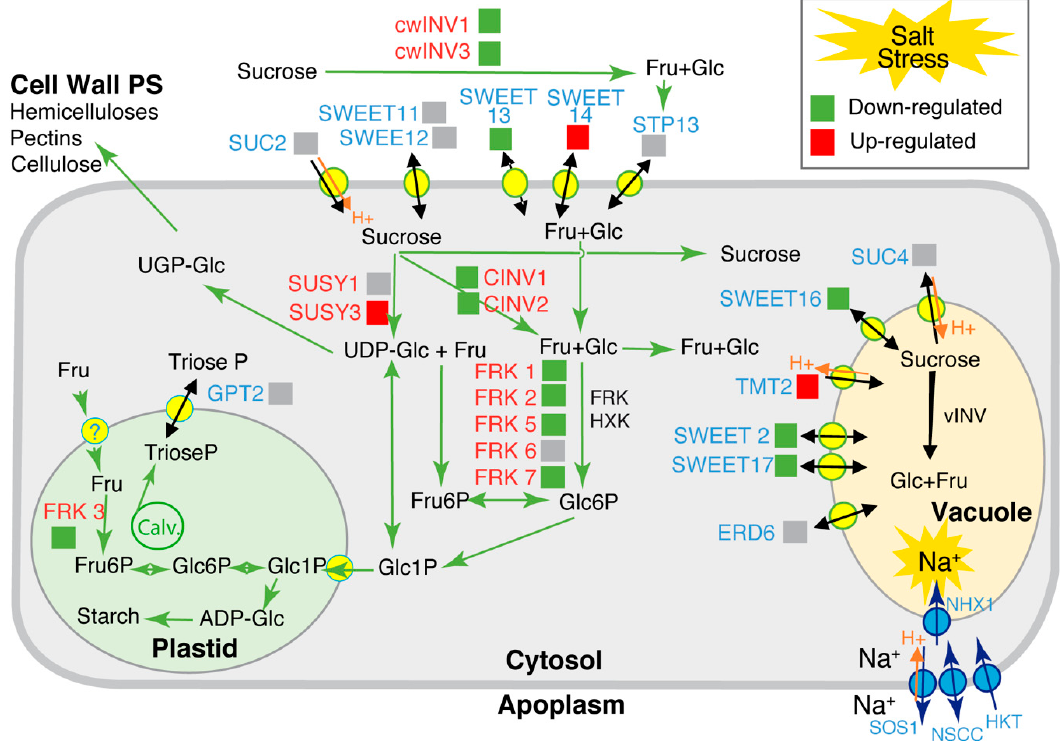
Figure 5. Scheme summarizing the expression data for genes involved in sugar transport ( TMT2 , SWEET2 , SWEET13 , SWEET14 , SWEET16 , SWEET17 ) and sugar homeostasis ( cwINV1 , cwINV2 , SUSY3 , CINV1 , CINV2 , FRK1 , FRK2 , FRK3 , FRK5 and FRK7 ) in the heterotrophic stem tissue under compared to controls. Red squares indicate genes upregulated in response to salt stress and green squares correspond to downregulated ones. Gray squares indicate genes with no significant